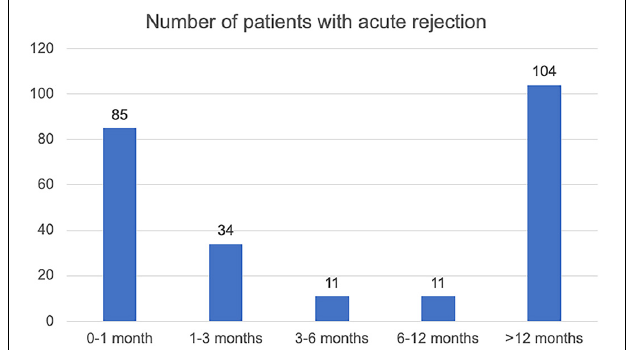
FIGURE 1 | Number of patients who experienced AR in different